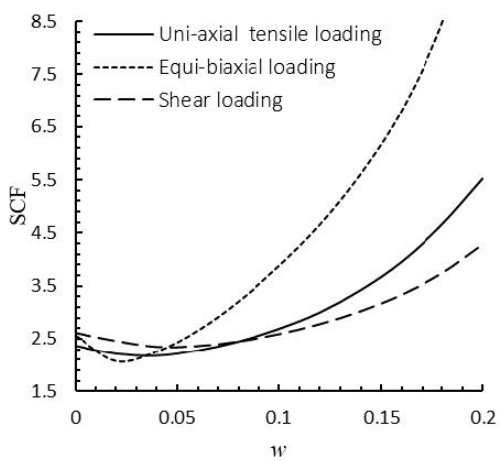
Figure 17. Variations of the SCF with w for quasi-square cutout ( c = 1).